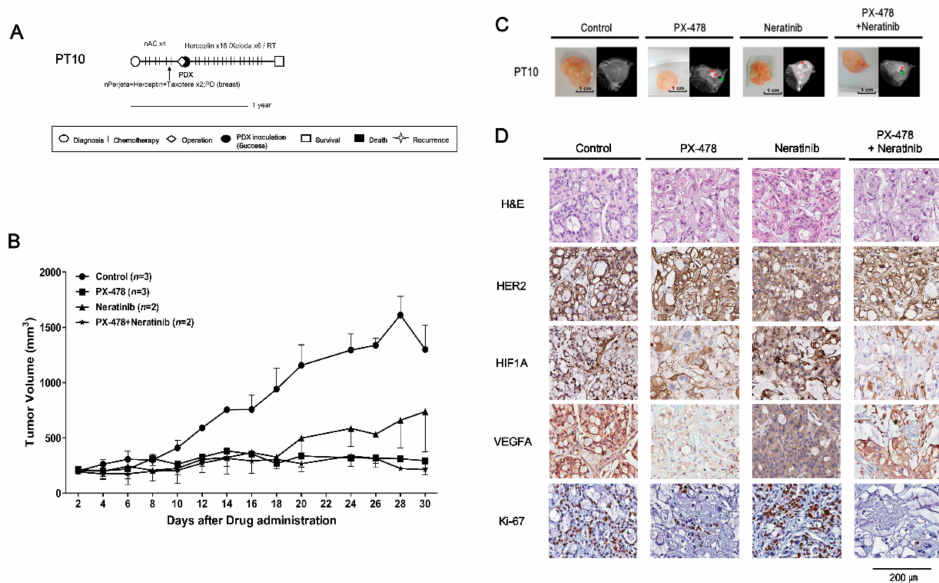
Figure 5. In vivo e ffi cacy of PX-478 and neratinib against PDX models from PT10 (HR − / HER2 +